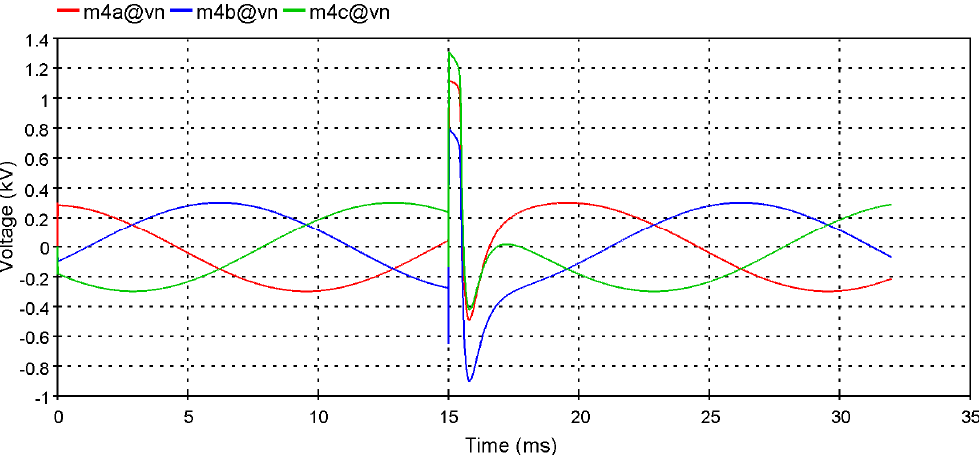
Figure 14. Limited overvoltage at the secondary side of the auxiliary transformer with SPD ideally